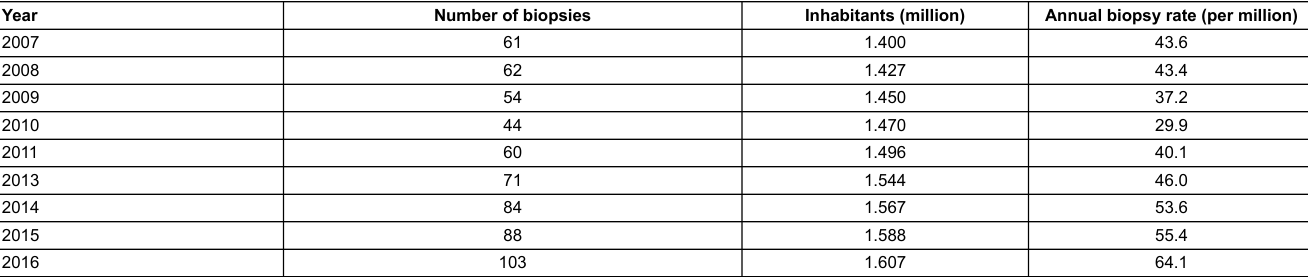
Table 2: Annual kidney biopsy rate between 2007 and 2016 per million inhabitants. There was a significant increase (p = 0.007) in the total number of kidney biopsies performed in the western region of Switzerland (all diagnoses confounded, and excluding transplant biopsies). Year Number of biopsies